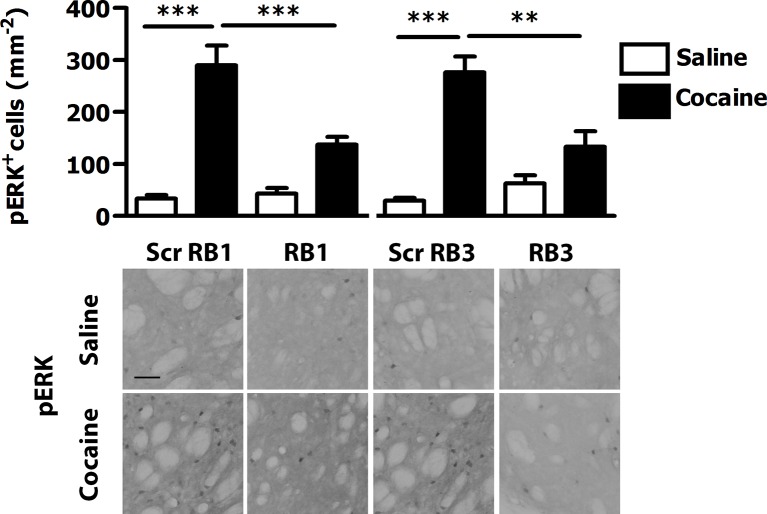
RB1 and RB3 have an inhibitory effect on cocaine-induced ERK phosphorylation.RB1 (20 mg/kg), RB3 (20 mg/kg), or the scrambled peptides (Scr) were administered to wild-type mice 1 hr before an acute cocaine (25 mg/kg) or saline injection. After 5 min mice were perfused. Immunohistochemistry was performed with anti-phospho p44/42 MAP kinase (Thr202/Tyr204, scale bar 30 μm). Quantification of phospho-ERK positive cells shows a significant inhibitory effect of RB1 and RB3 on cocaine-induced ERK activation in the ventral striatum. Two-way ANOVA: effect of RB1 F1,14 = 18.73, p<0.001, effect of cocaine F1,14 = 111.87, p<0.0001, effect of interaction F1,14 = 23.95, p<0.001; Bonferroni’s post-hoc, Scr RB1 saline (n=5) vs Scr RB1 cocaine (n=3) p<0.001, Scr RB1 cocaine (n=3) vs RB1 cocaine (n=5) p<0.001. Two-way ANOVA: effect of RB3 F1,14 = 6.26, p<0.05, effect of cocaine F1,14 = 52.11, p<0.0001, effect of interaction F1,14 = 16.06, p<0.01; Bonferroni’s post-hoc, Scr RB3 saline (n=5) vs Scr RB3 cocaine (n=3) p<0.001, Scr RB3 cocaine (n=3) vs RB3 cocaine (n=5) p<0.01. **p<0.01, ***p<0.001. Data are shown as mean with SEM.